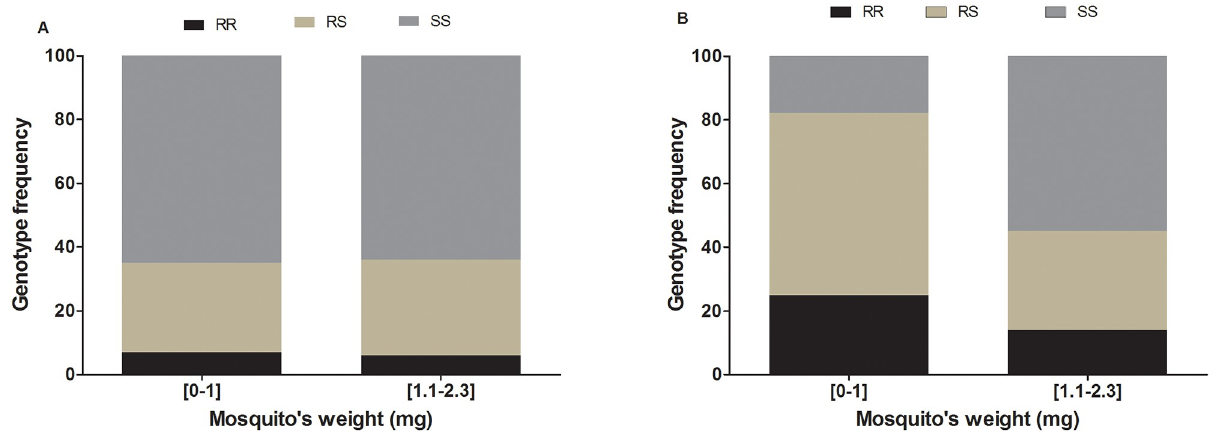
Fig 1. Effect of metabolic resistance on An . funestus mosquito weight. Distribution of genotypes of L119F-GSTe2 (A) and CYP6P9a -R (B) markers according to the weight.